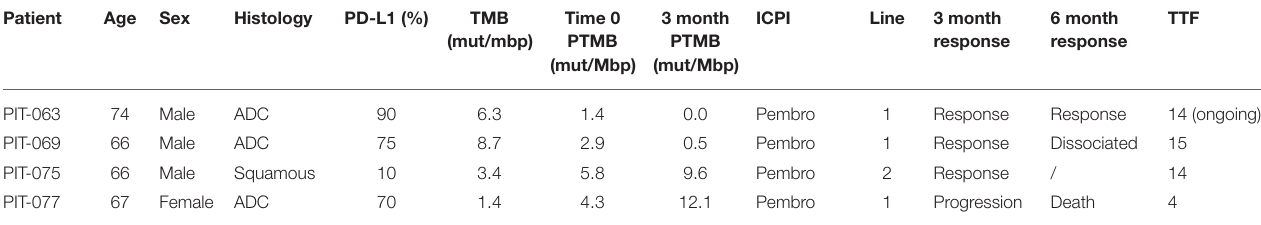
TABLE 1 | Patient and tumor characteristics. Patient